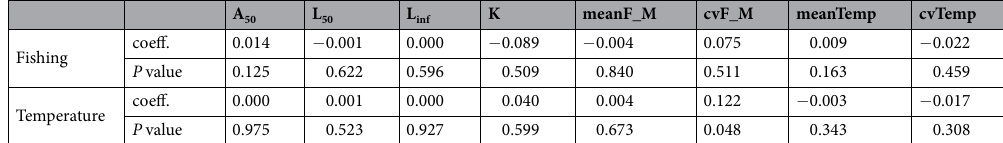
Table 3. Results of univariate linear regression analysis on % variation explained by fishing or temperature versus each life history trait, mean mortality ratio (meanF_M), CV of mortality ratio (cvF_M)), mean temperature (meanTemp), and CV of temperature (cvTemp).